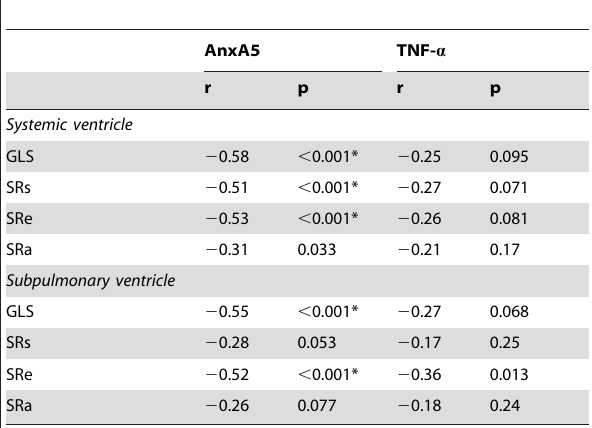
Abbreviations as in Table 1. *statistically significant after Bonferroni correction.